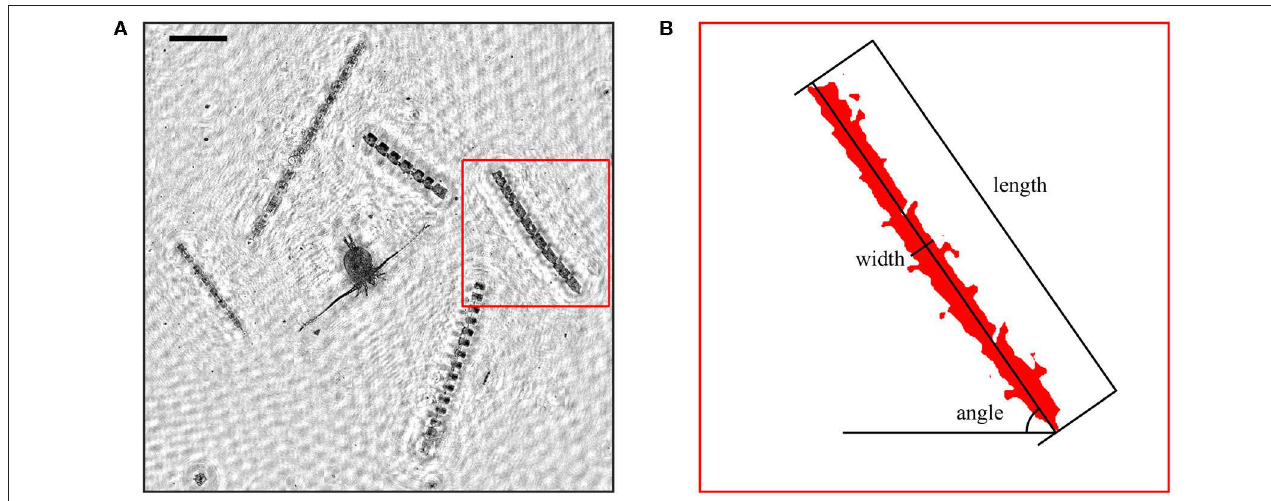
FIGURE 1 | (A) A portion of an extended depth of field (EDF) image obtained after holographic reconstruction showing multiple colonies of Ditylum brightwellii and a copepod. Scale bar (upper left) represents 500 µm. (B) Illustration of the length, width, and angle measurements from image analysis for one D. brightwellii colony.